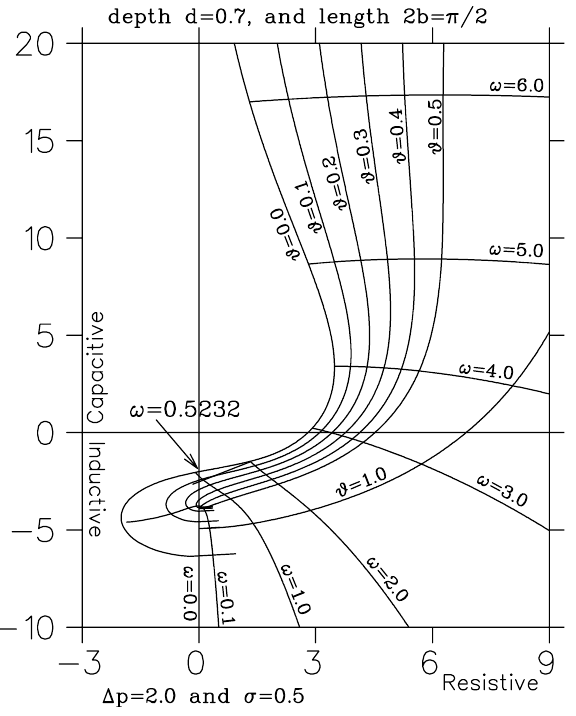
two modes possible with pure inductive impedance (see Fig. 37), and when s (cid:3) D p , bd (cid:3) p there is one stationary mode possible with capacitive impedance (see Fig.